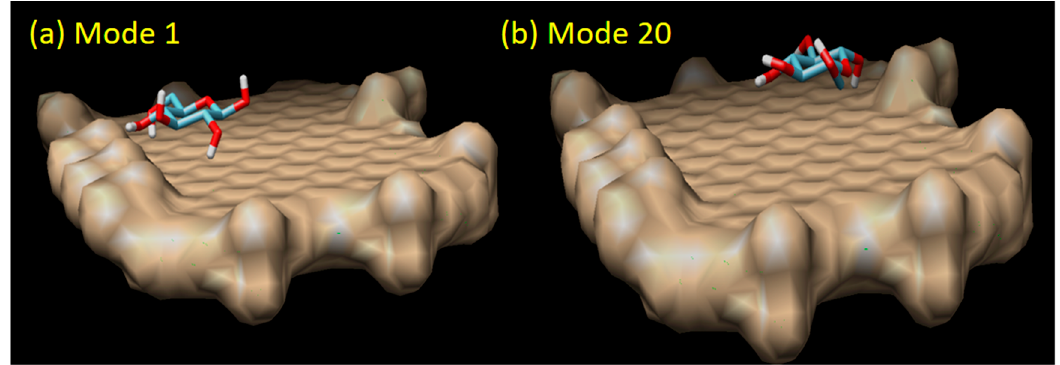
Figure 6. The direct sensing model of graphene oxide and glucose molecule in mode 1 (the strongest binding affinity of − 4.20 kCal/mol) and mode 20 (the weakest binding affinity of − 3.70 kCal/mol).